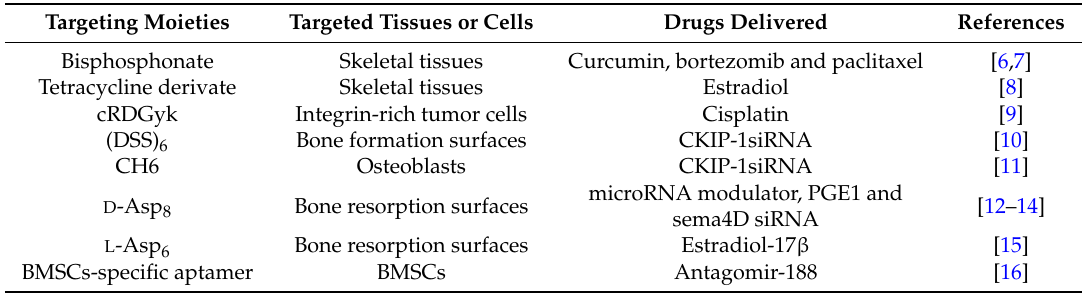
Table 1. Examples of targeting moieties used in targeted delivery systems for molecular therapy in skeletal